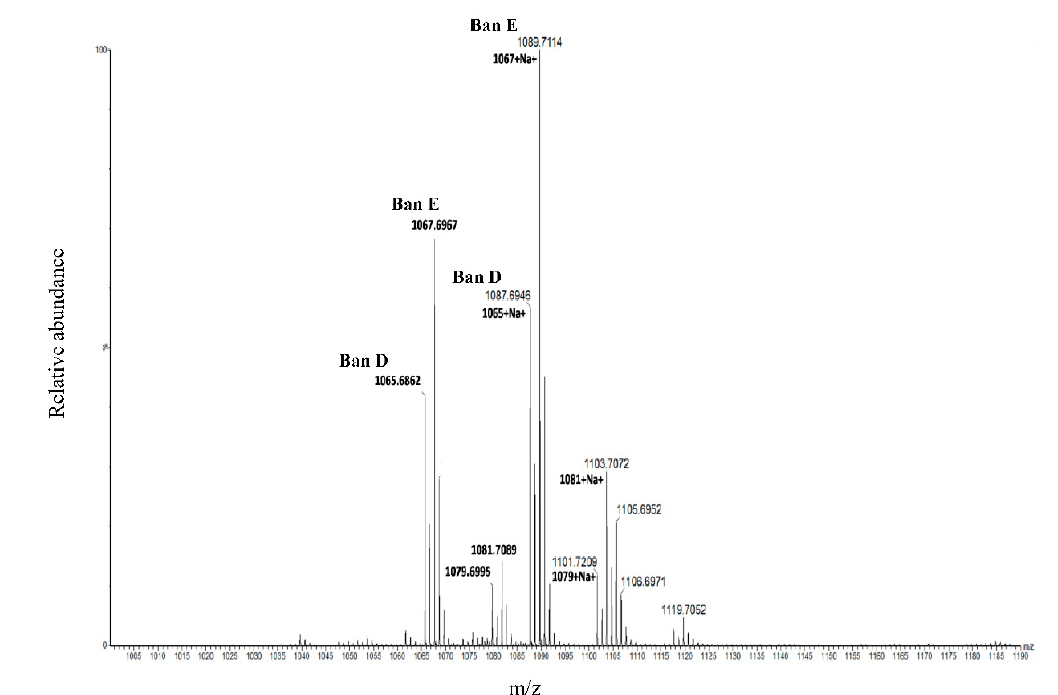
Figure 1. Kendrick mass defect molecular formular assignment of crude CLP extract from Pseudomonas sp. COW3. ESI QTOF mass spectrum in the mass range 1000-1190 m / z obtained from the direct introduction of crude CLP extract from COW3. Table 1. [M + H] + values extracted from HRMS-spectrum and their corresponding molecular formula (MF) assigns using Kendrick Formula Predictor (https://bioinfo.cristal.univ-lille.fr/kendrick- webapp/).